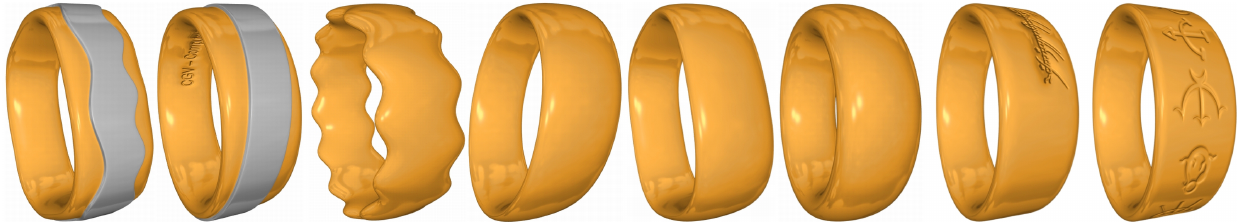
rings. Features, like engravings, recesses, different materials, unusual forms and gems, can be created and